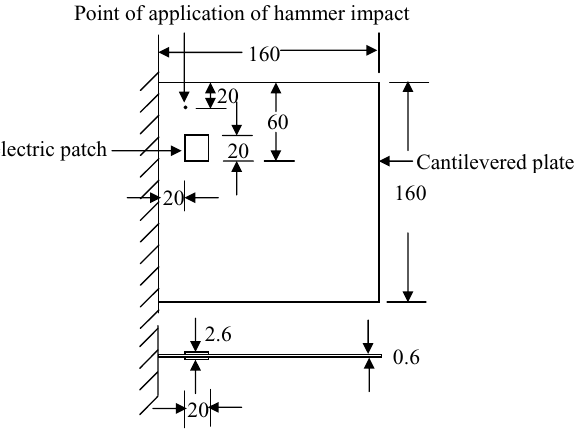
Fig. 1. Test plate instrumented with piezoelectric patches (dimensions in mm).